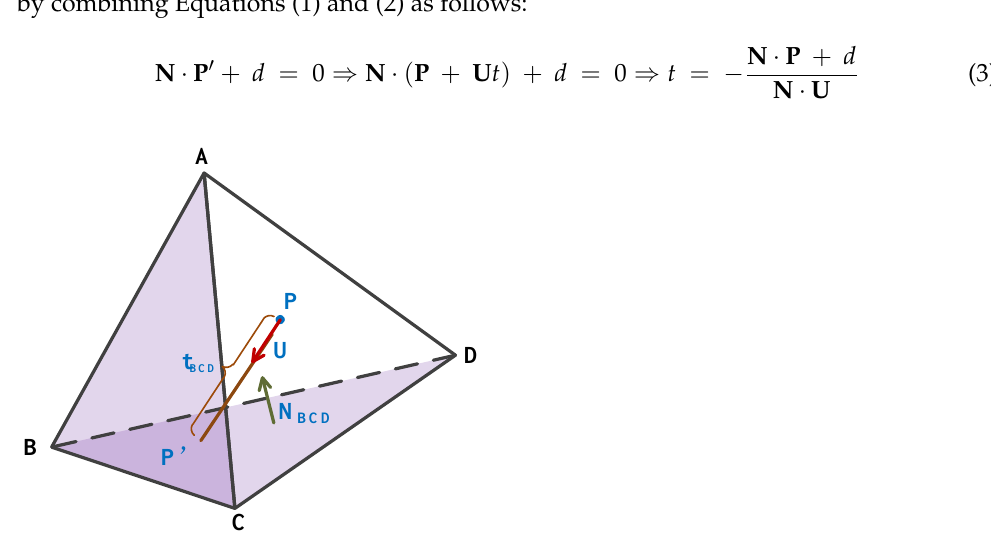
Figure 3. Diagram of photon–tetrahedron interaction. Planes ABC and BCD satisfy the judgment. t BCD represents the photon propagation distance to plane BCD, and N BCD denotes the inward unit normal vector of plane BCD.